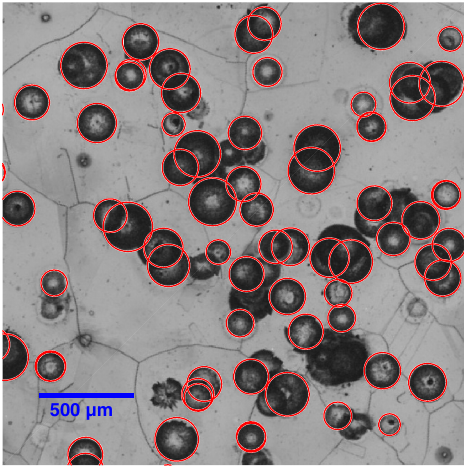
FIG. 6. Optical microscope image of soft Cu CERN surface with several BD craters visible and detected by machine on a cathode surface of soft Cu CERN are shown in Fig. 6. Machine vision algorithm was used to detect the